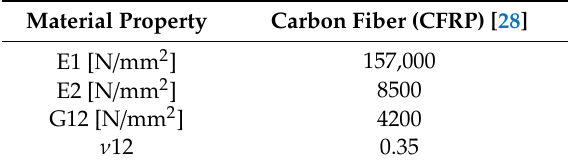
Table 1. Material properties of carbon fiber reinforced polymers (CFRP)